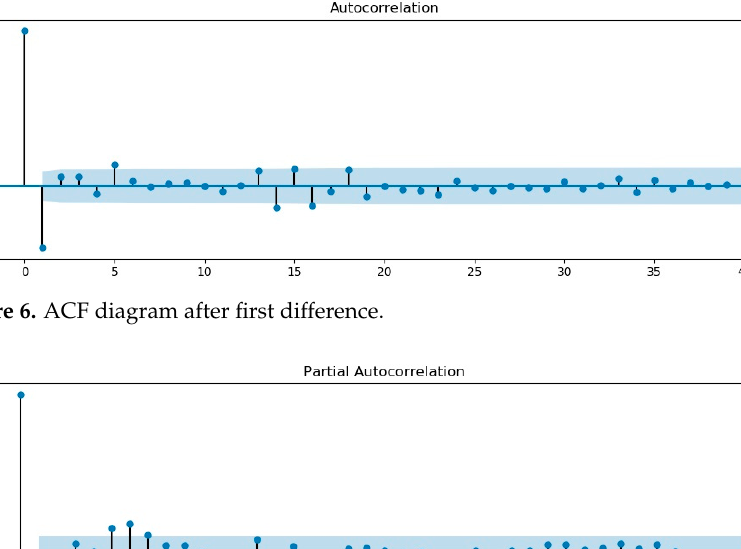
10 of 19 Table 1. Comparison of ADF test results. Comparison Item